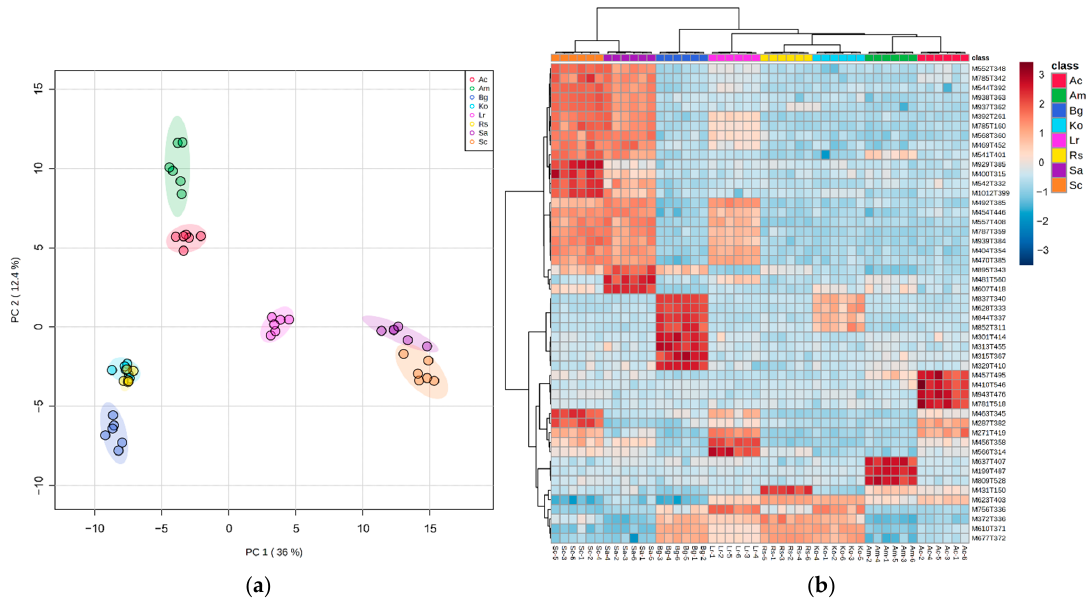
Figure 1. UHPLC-MS fingerprints of leaf methanolic extracts of Aegiceras corniculatum (red), Avicennia marina (green), Lumnitzera racemosa (pink), Bruguiera gymnorhiza (dark blue), Kandelia obovata (light blue), Rhizophora stylosa (yellow), Sonneratia apetala (purple) and S. caseolaris (orange): ( a ) principal component analysis where each sample is represented by a dot; ( b ) hierarchical clustering heatmap of most significant m / z features amongst species groups (ANOVA, p < 0.05). Each colored cell corresponds to a normalized, log10-transformed and mean-centered abundance value. Samples are in rows and m / z features in